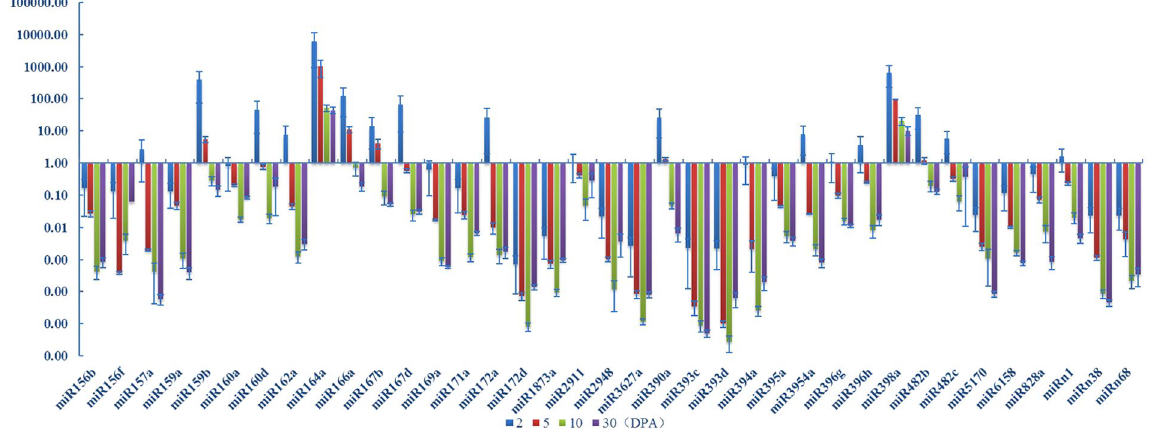
Figure 2. A total of 54 miRNAs were selected and profiled during the cotton fiber initiation and early development. This figure only show the miRNAs with significant expression during fiber elongation and secondary wall formation in cotton cultivar Xu142